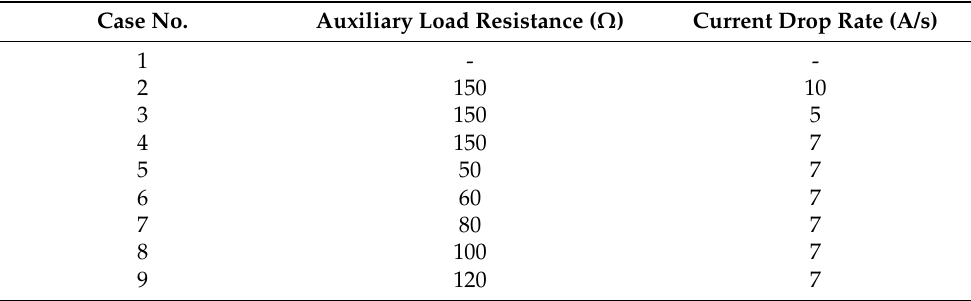
Table 3. Shutdown operating parameters of the PEMFC system in a different case. Case